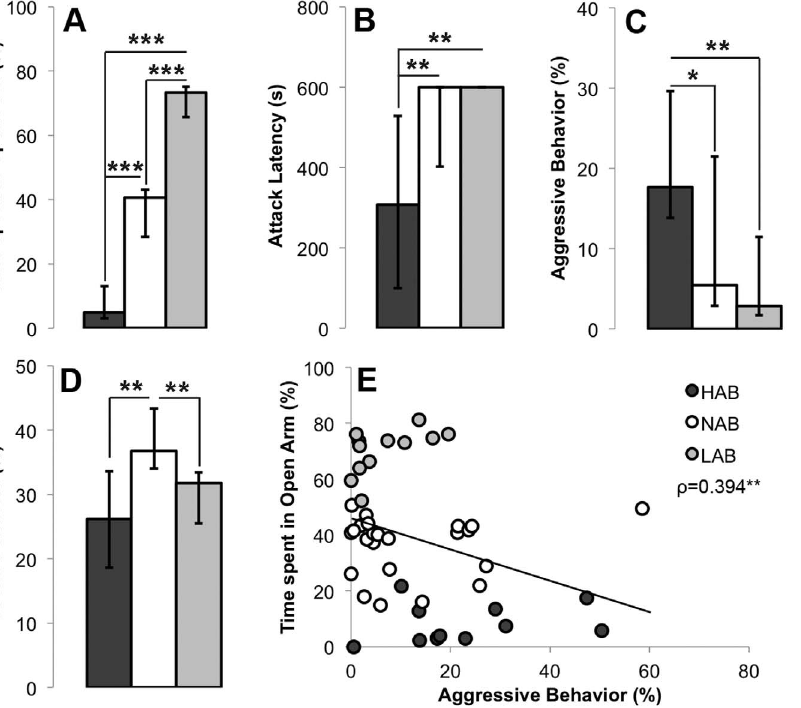
Figure 3. Behavioral profile of adolescent (7–8 week old) virgin female HAB (n=12), NAB (n=23) and LAB (n=12) rats in the EPM and FIT. A: Percentage of time spent in the open arms of the EPM; B–D: Attack latency, percentage of time displaying aggressive behavior and percentage of time displaying social behavior in a 10-min FIT. Data in A–D are medians and quartiles. E: Spearman’s correlation coefficient between percentage of time spent in the open arms of the EPM and percentage of time spent displaying aggressive behavior in the FIT two days later. *P , 0.05; **P , 0.01; ***P , 0.001. doi:10.1371/journal.pone.0091701.g003 PLOS ONE |